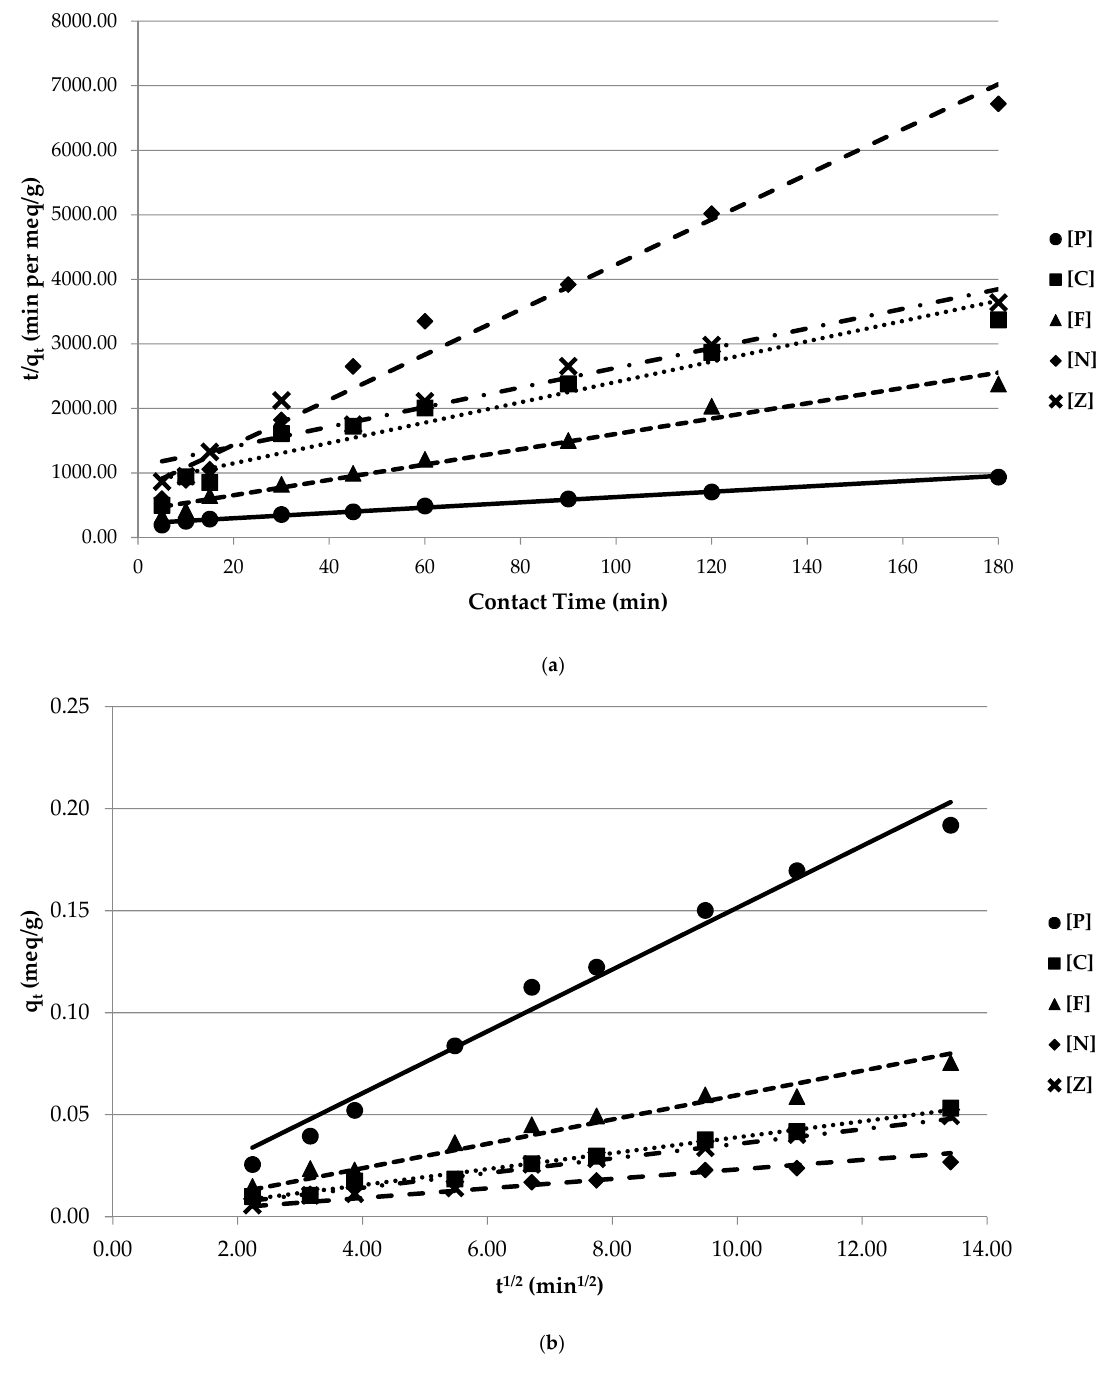
Figure 2. Single ‐ component system kinetic model plots: ( a ) pseudo ‐ second ‐ order; ( b ) intra ‐ particle diffusion.